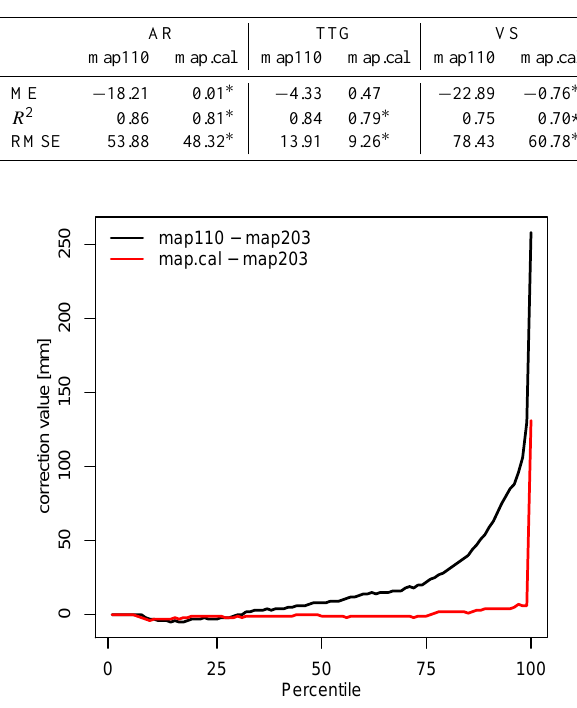
Table 3. Mean error (ME), coefficient of determination ( R 2 ) and root-mean-squared error (RMSE) of map110 and map.cal for the three regions: Alpine Rhine (AR), Thur/Töss/Glatt (TTG) and Valais (VS). Stars mark significant differences between map110 and map.cal (at a 95% confidence level).